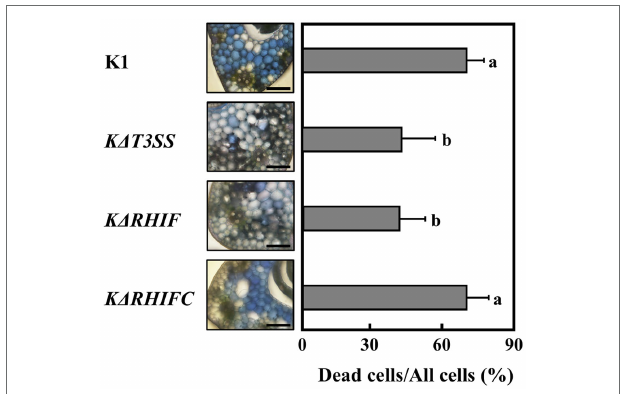
FIGURE 6 | Role of KRHIF in induction of finger millet cell death. Finger millet sheath cross-sections were inoculated with K1, K Δ T3SS , K Δ RHIF , and K Δ RHIFC , and 12 h after inoculation, Evans blue staining was performed. Scale bar represents 100 μ m. Light graphs show the percentage of dead cell in leaf sheath sections of finger millet. Each determination was done with at least 100 cells in each experiment. Error bars represent standard deviation of three independent experiments. Values followed by a different letter were significantly different according to Tukey-Kramer test ( p <